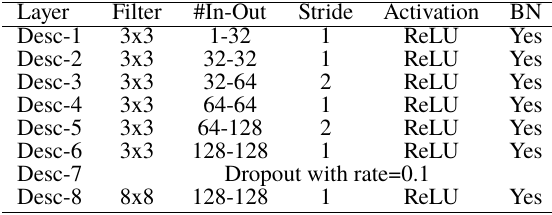
Table 1. Descriptor Network architecture. #In-Out: number